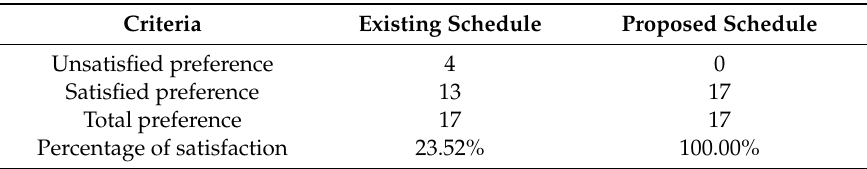
Table 7. Computational